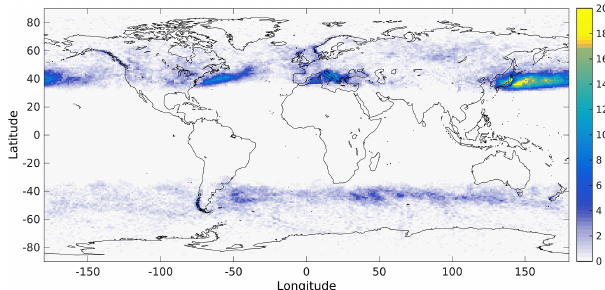
Figure 5. Average number of winter thunderstorm days per year ( T w ) for the period